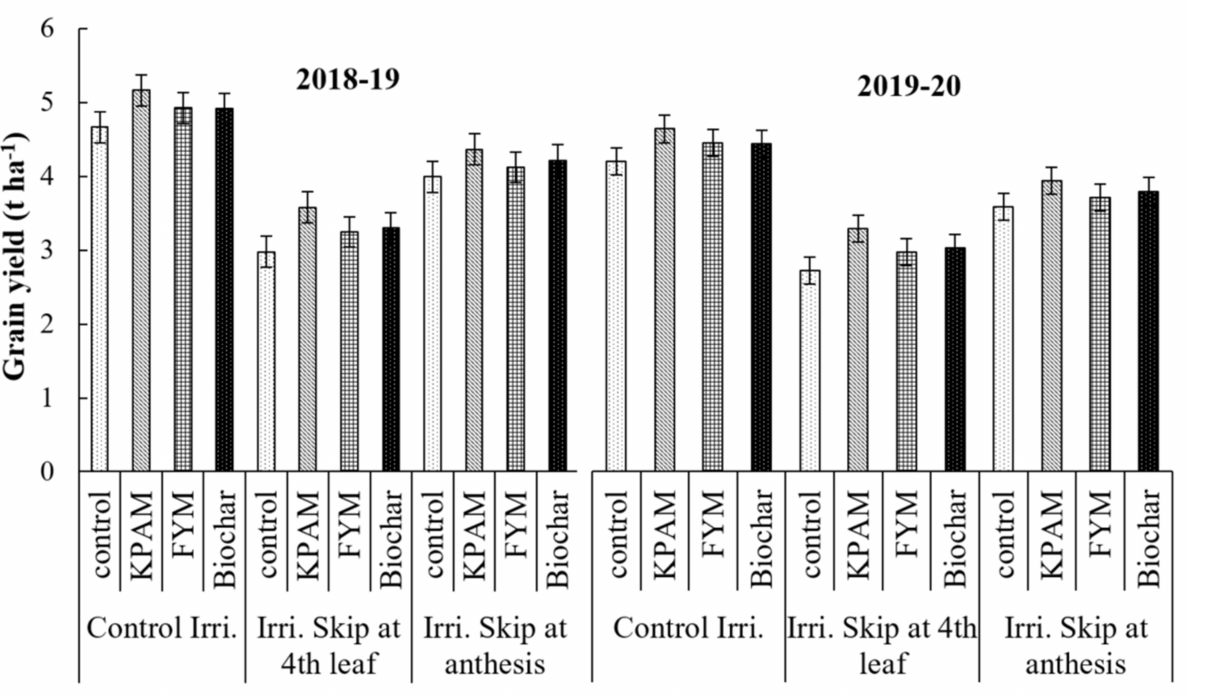
Figure 13. Effect of soil amendment materials on grain yield in the wheat crops grown under normal and water stress imposed by skipping irrigation at 4th leaf and anthesis stage of growth (mean values ±